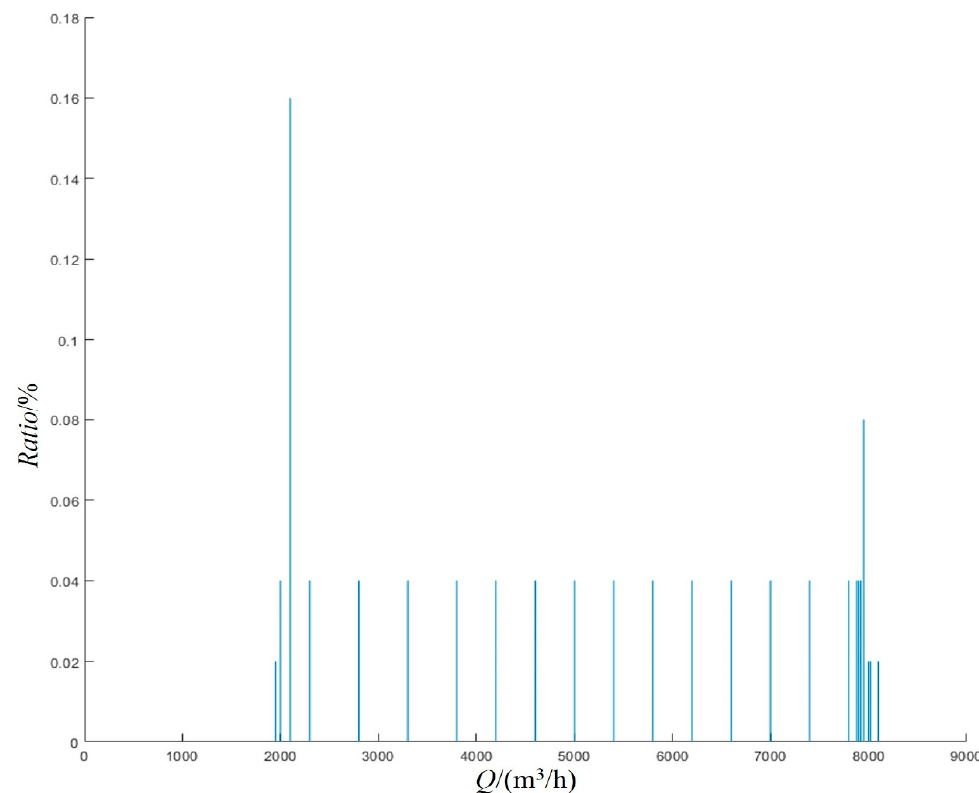
Figure 7. Annual water consumption statistics of the pumping station.